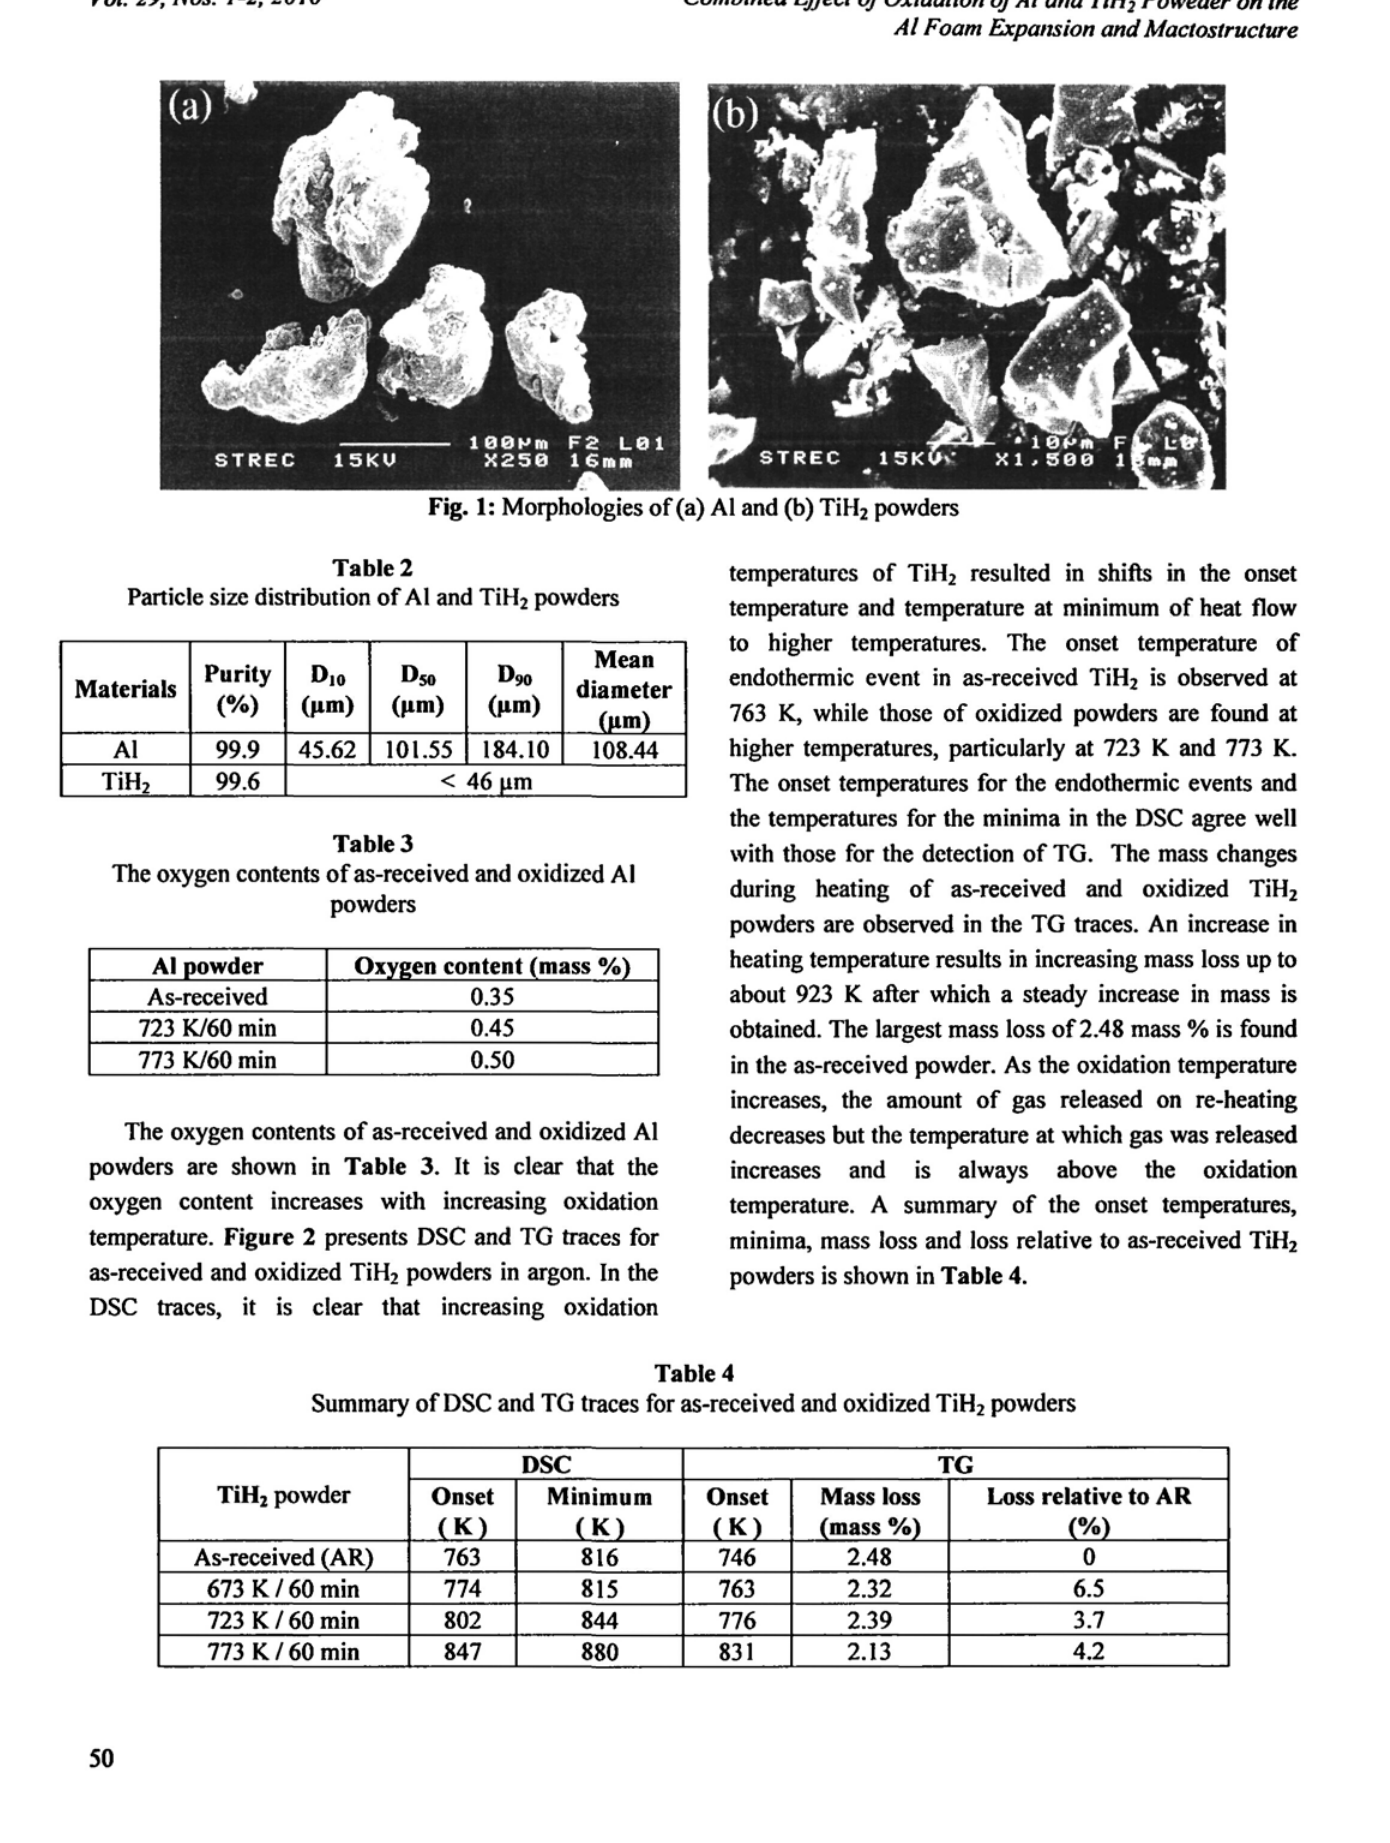
Fig. 1: Morphologies of (a) Al and (b) TiH